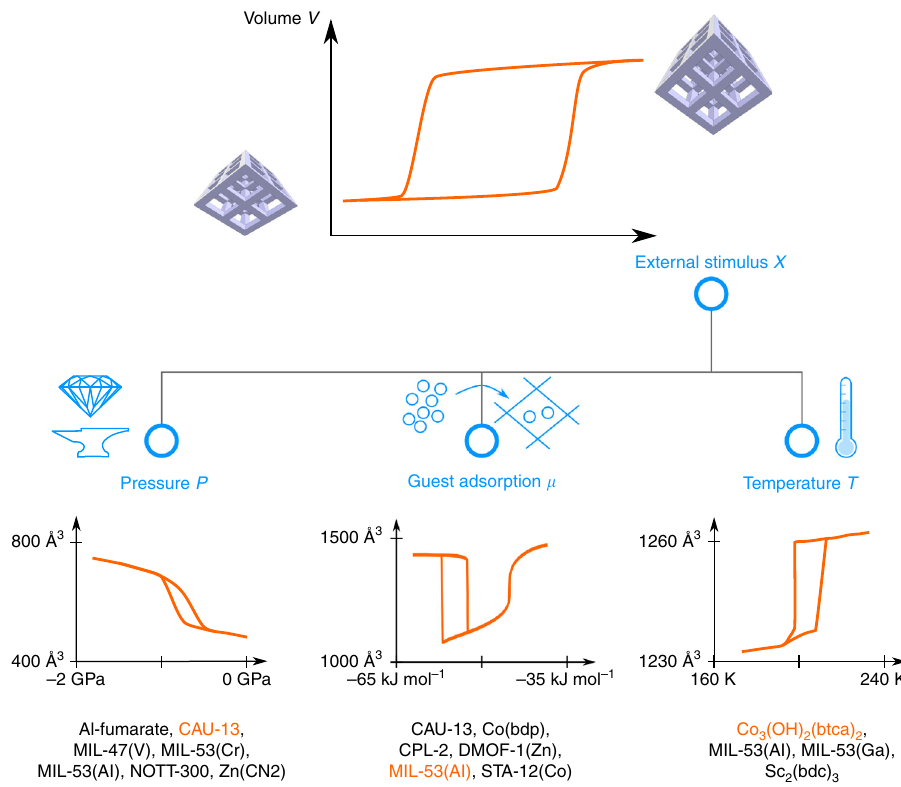
Fig. 2 Illustration of volume pro fi les for three types of external stimuli. The stimuli are mechanical pressure, chemical potential and temperature. Examples of soft porous materials for which such pro fi les have been determined are indicated in the bottom of the fi gure (Al-Fumarate 17 , CAU-13 48 , MIL-47(V) 18 , MIL-53(Cr) 49 , NOTT-300 48 , Zn(CN) 2 50 , Co(bdp) 35 , CPL-2 51 , DMOF-1(Zn) 36 , MIL-53(Al) 12, 19, 52 , STA-12(Co) 53 , Co 3 (OH) 2 (btca) 2 54 , MIL-53(Ga) 26 and Sc 2 (bdc) 3 55 ). The shown pro fi les correspond, from left to right, to CAU-13, MIL-53(Al) and Co 3 (OH) 2 (btca) 2 . For each material, the chemical formula and building blocks are given in Supplementary Table